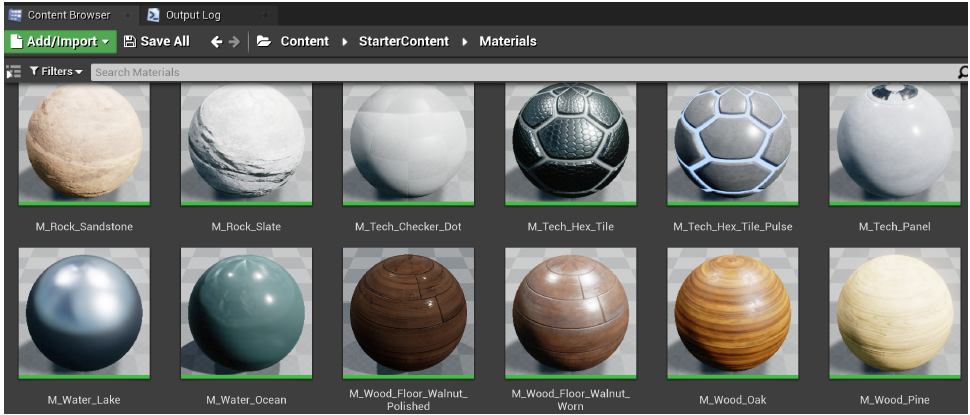
Figure 15. Example of realistic materials available in Unreal